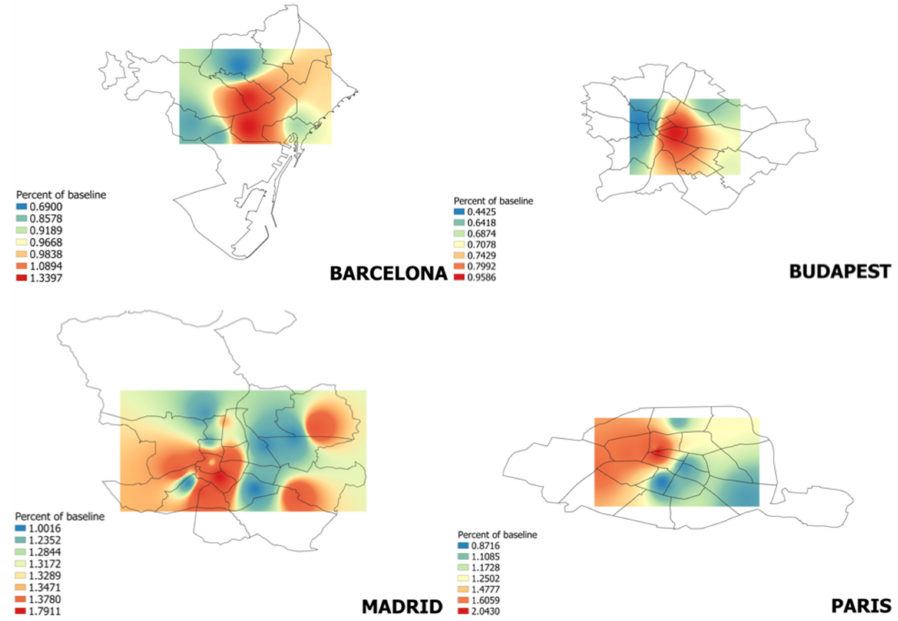
Figure 8. Spatial distribution of percentages of avoided premature mortality within selected cities due to exposure to NO 2